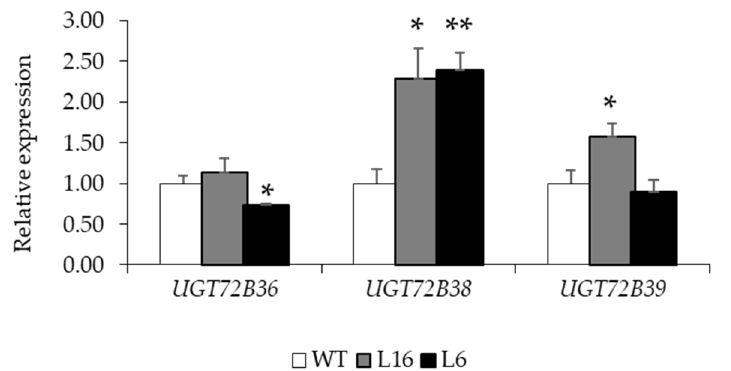
Figure 6. Expression level of the 3 other poplar UGT72Bs in the xylem of three-month-old ugt72b37 mutant and WT lines cultivated in soil, as assessed by RT-qPCR. The expression level of each gene in WT was defined as reference level, with a relative value = 1. Values are means of four biological replicates ( ± SE). *: significative difference ( p < 0.05) compared with the WT, **: significative difference ( p < 0.01) compared with the WT ( t